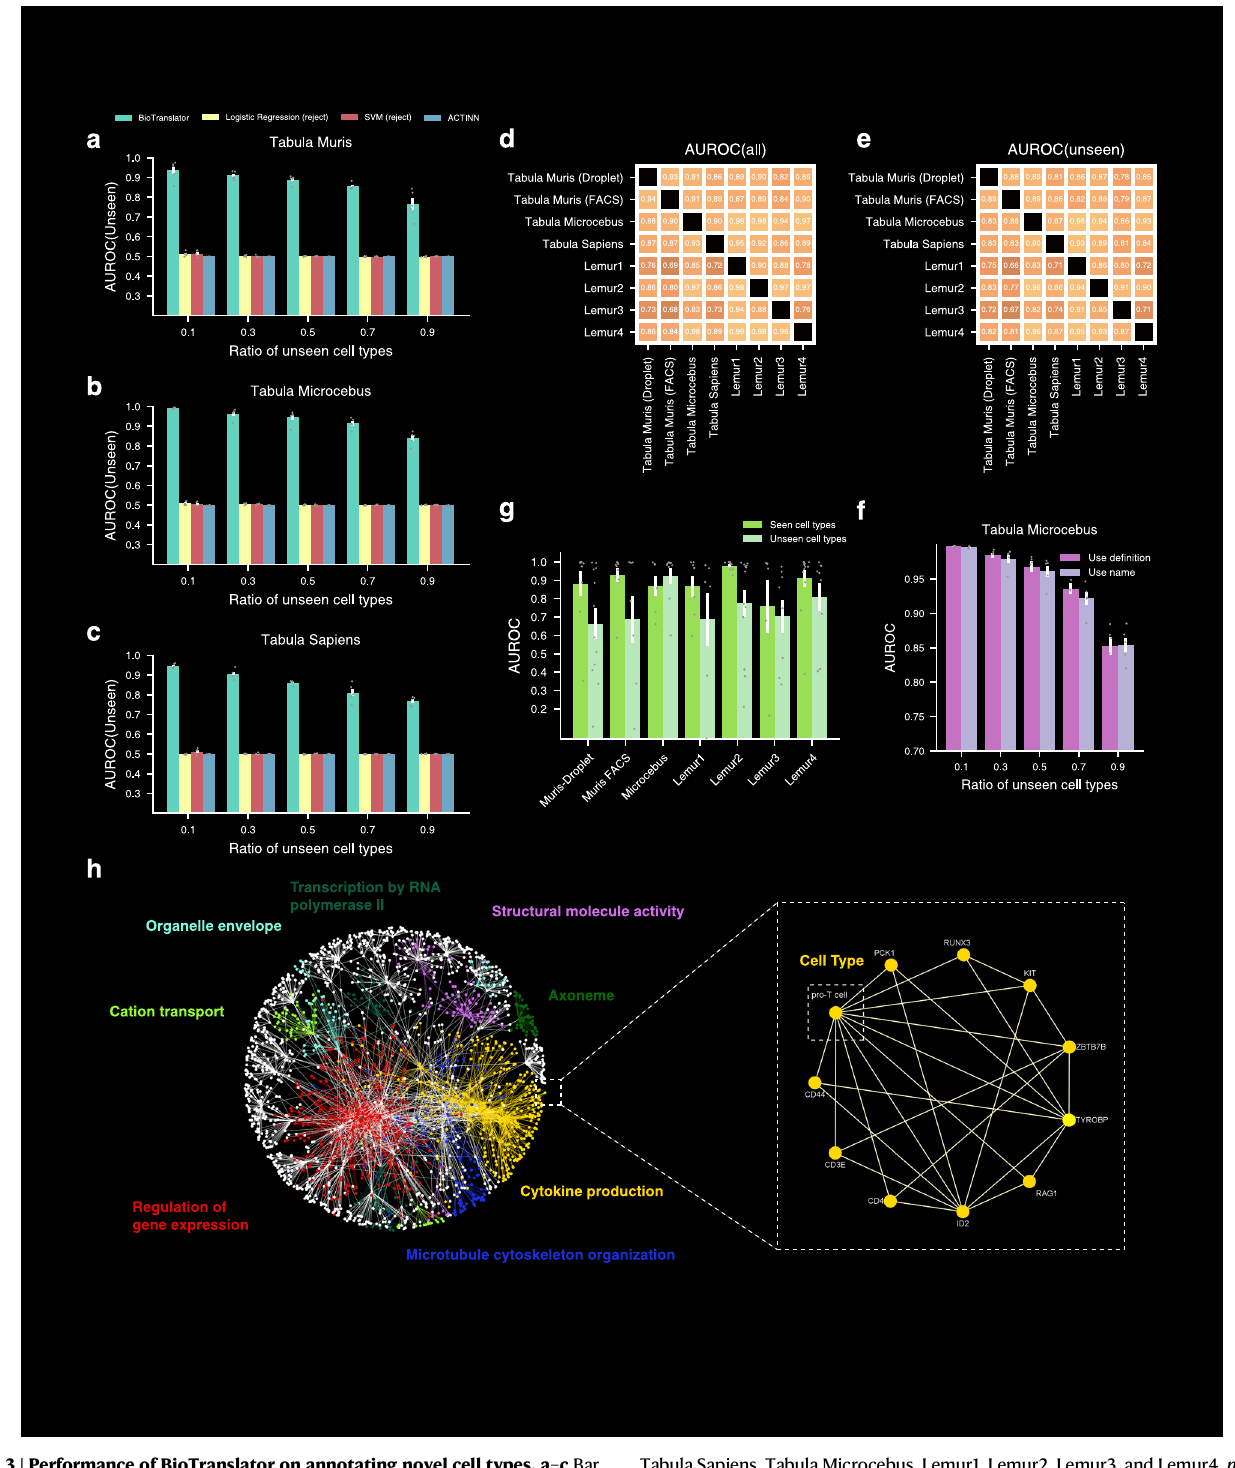
TabulaSapiens, Tabula Microcebus, Lemur1, Lemur2, Lemur3, and Lemur4. n =12, 7,9,6,13,8,9unseencelltypesexaminedonTabulaMuris(Droplet),TabulaMuris (FACS), Tabula Sapiens, Tabula Microcebus, Lemur1, Lemur2, Lemur3, and Lemur4.Errorbarrepresentsthestandarderroracrosstheexaminedcelltypesand thecenteroftheerrorbaristhemeanvalue. g Barplotcomparingtheperformance of BioTranslator using cell type textual descriptions to the performance using cell type names. Error bar is the standard error in fi vefold cross-validation. Center of theerrorbaristhemeanvalue. h Celltypemarkergenenetworkconstructedusing the textual embeddings from BioTranslator. Eight communities are detected and each is associated with a GO term using text-based GO